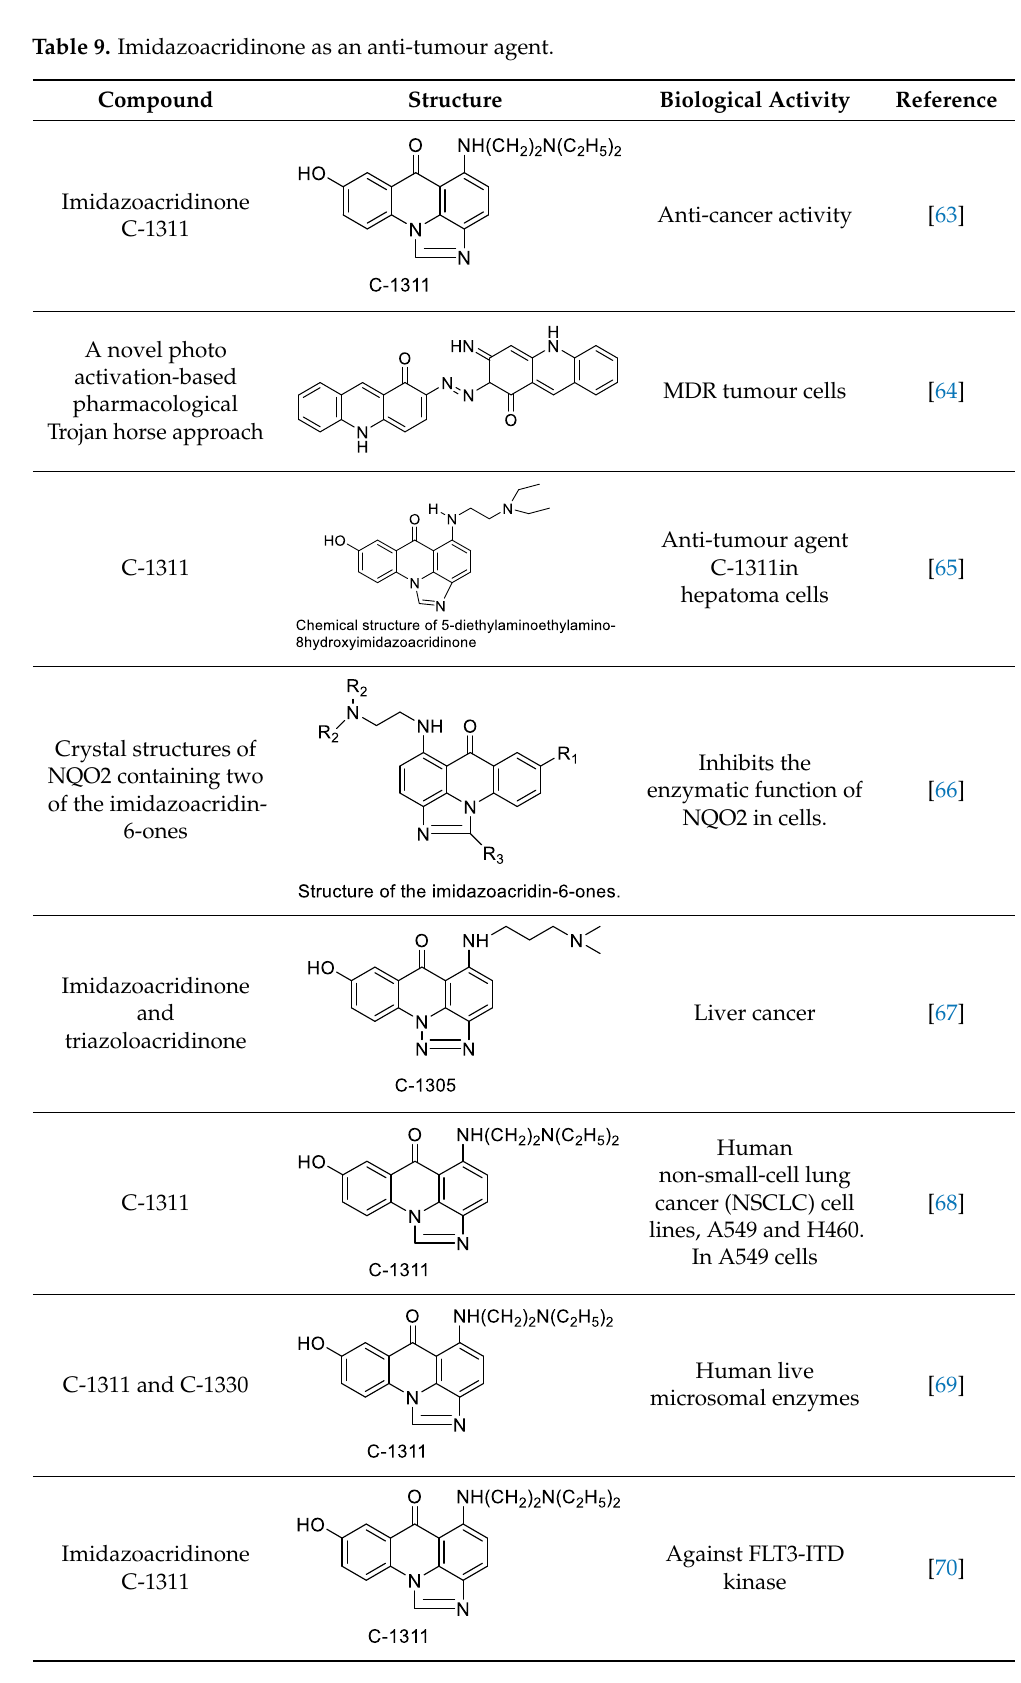
Table 9. Imidazoacridinone as an anti-tumour